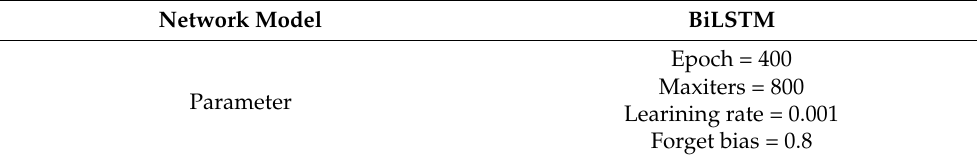
Table 5. Network model